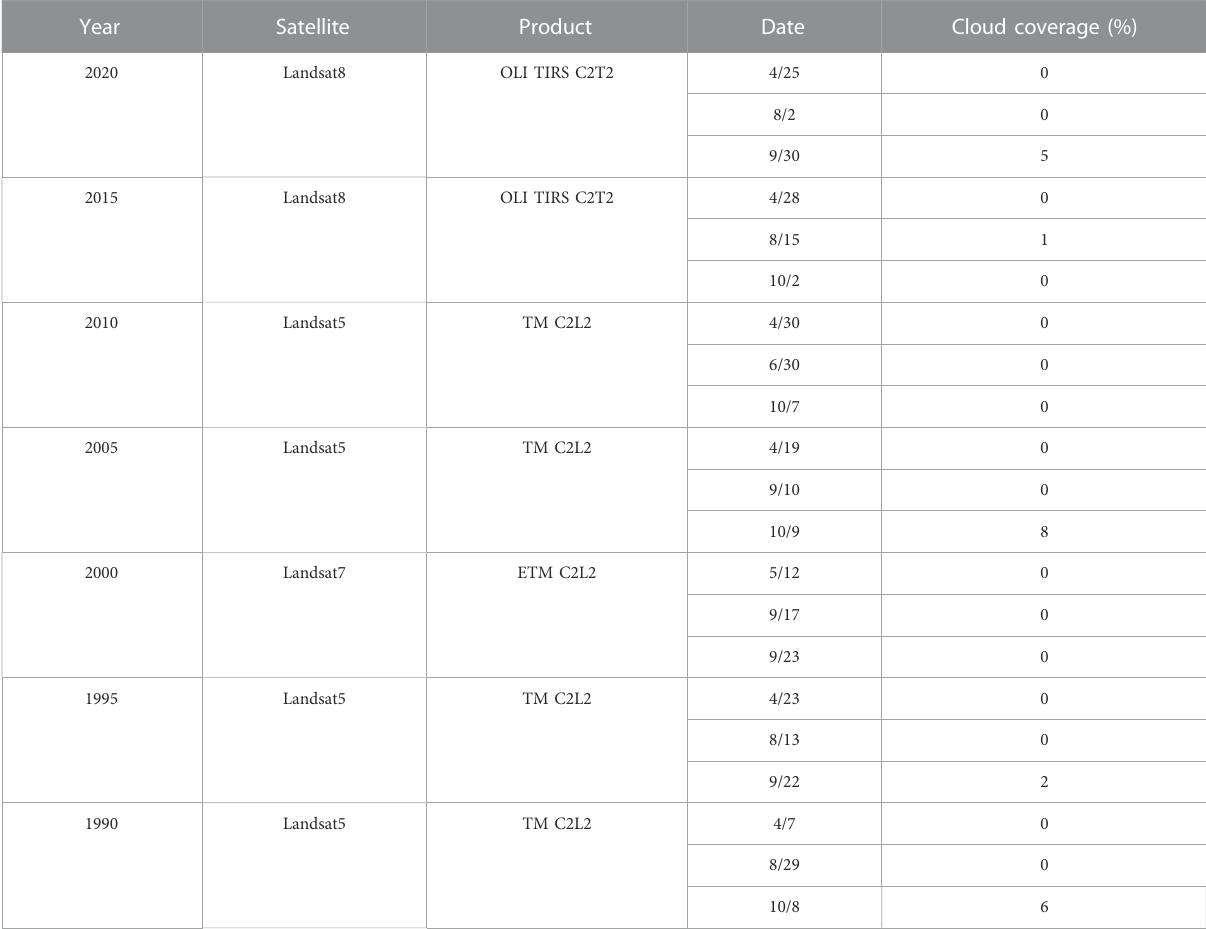
TABLE 1 Details of satellite data used in this